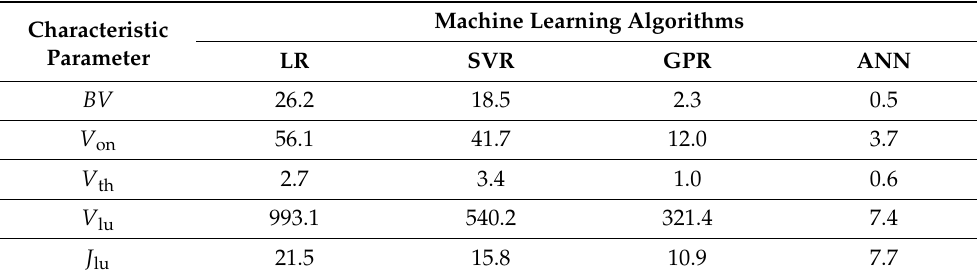
Table 2. Average errors (%) of predictors constructed with different algorithms.